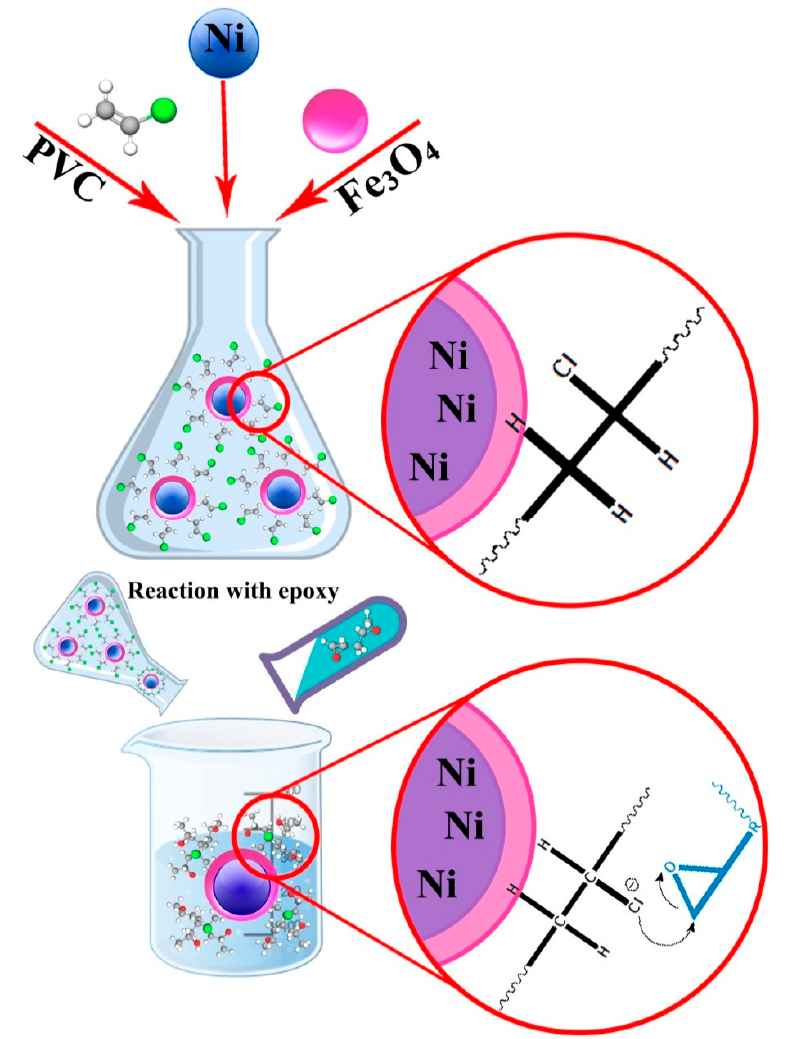
Figure 9. Possible reaction between PVC and epoxy ring.